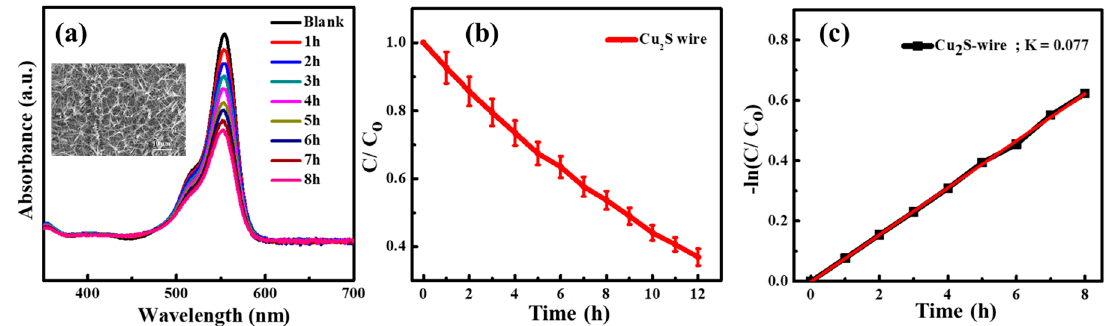
Figure 5. The illustrations display the performance of the photocatalytic activity of the Cu 2 S nanowires over various irradiation periods. ( a ) UV/Vis absorption intensity of the RhB with a series of various times. The upper insert is an SEM image of the experimental sample. ( b ) Photocatalytic degradation of RhB under UV illumination. ( c ) The kinetic formula of RhB photodegradation, K, is a constant of photodegradation rate.